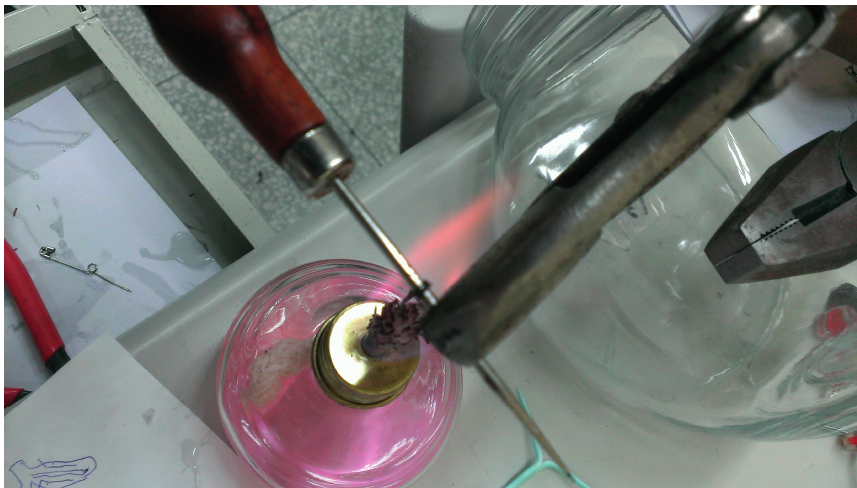
Figure 8. Direct heating of the